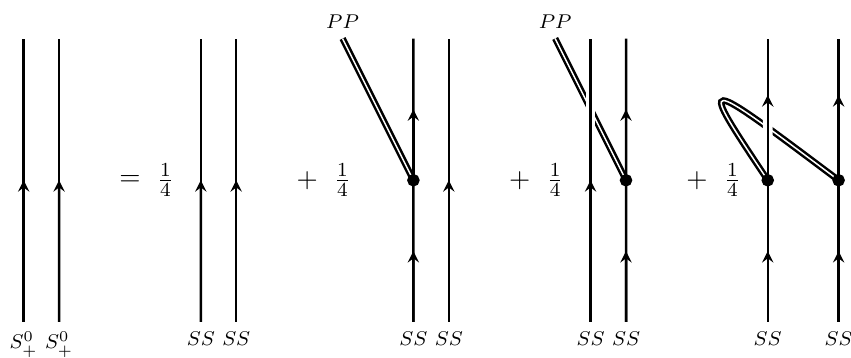
Figure 23 . A sample computation of fusion rules in shadow product of two equivariant toric codes with (cid:24) 1 = (cid:24) 2 : S 0 (cid:10) S 0 is by de(cid:12)nition a sum of four terms which involve associators and + +